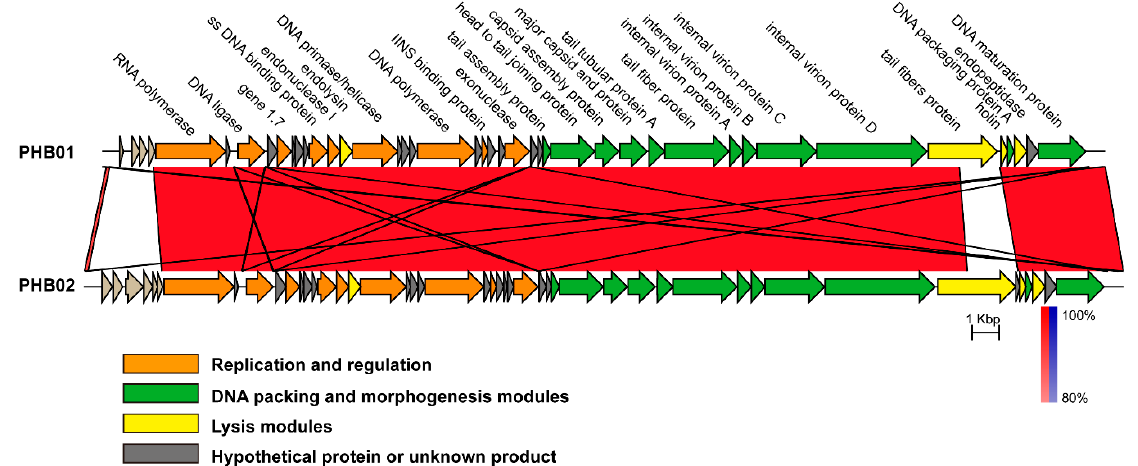
Figure 5. A co-linearity comparison diagram of the genomic organization at the nucleotide level between Pasteurella phages PHB01 and PHB02. The figure was generated via Easyfig v.2.0. The color code refers to the BLASTn identity of those regions between genomes. Arrows represent putative CDSs encoded by different genomes.